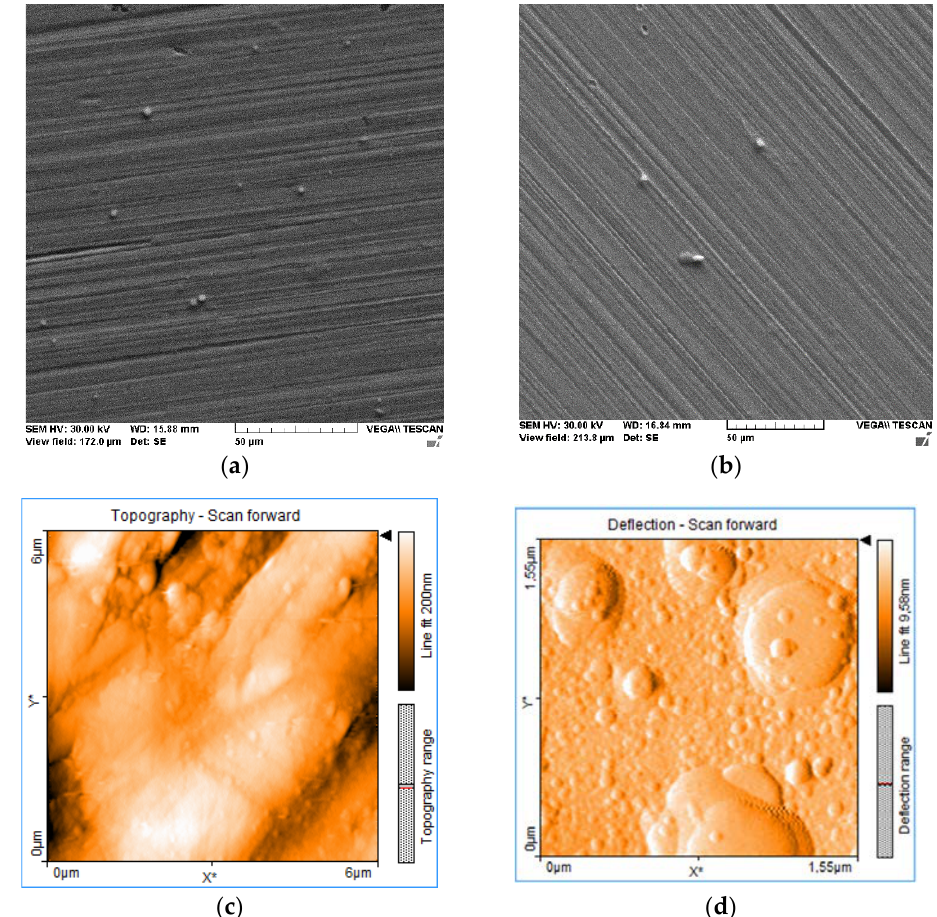
Figure 8. ( a , b ) SEM images of C1 and C2 layers and ( c , d ) AFM images of the ceramic layers obtained through PLD. ( c ) The surface layer obtained from the C1 target. ( d ) The surface layer obtained from the C2 target; () the C2